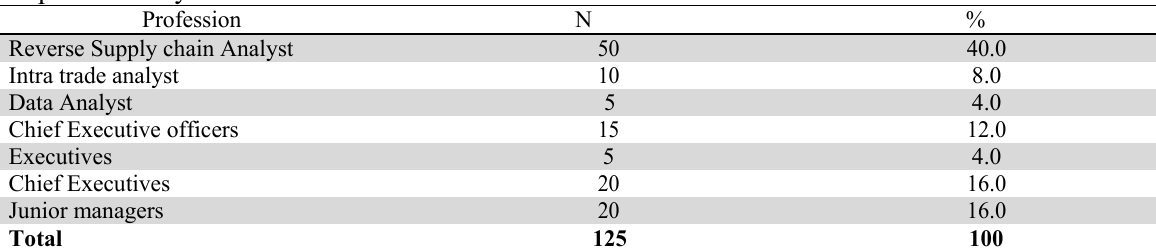
Response rate by